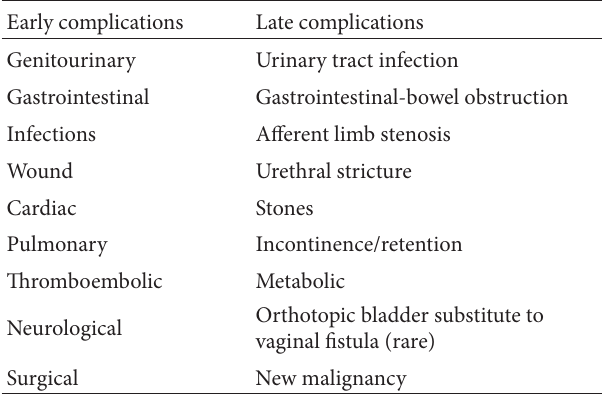
Table1:EarlyandlatecomplicationsofradicalcystectomywithOBS